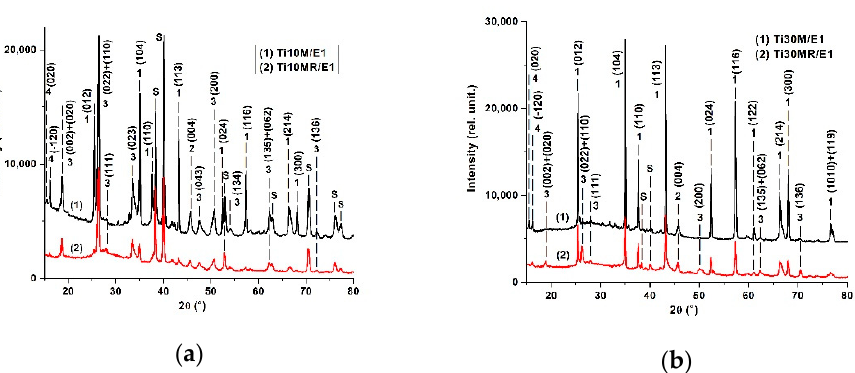
Figure 3. Qualitative phase analysis of the diffraction patterns of the Ti10M/E1 ( a ) and Ti30M/E1 ( b ) samples, before (1) and after (2) removing a 10 µm-thick surface layer. 1: α -Al 2 O 3 ; 2: γ -Al 2 O 3 ; 3: TiAl 2 O 5 ; 4: Na 2 Ti 4 O 9 ; S: Cp-Ti grade 2.